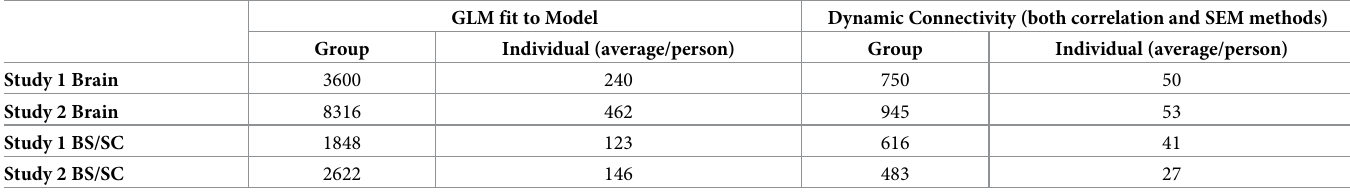
Table 1. The number of imaging volumes (i.e. time points) used for each calculation with each analysis method, at the group and individual levels.